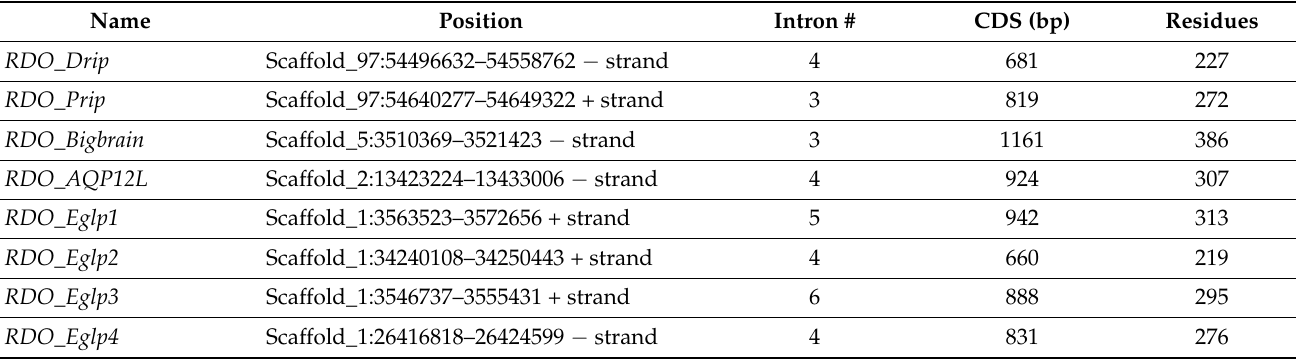
Table 4. Rhyzopertha dominica aquaporins (AQPs) predicted from manual genome